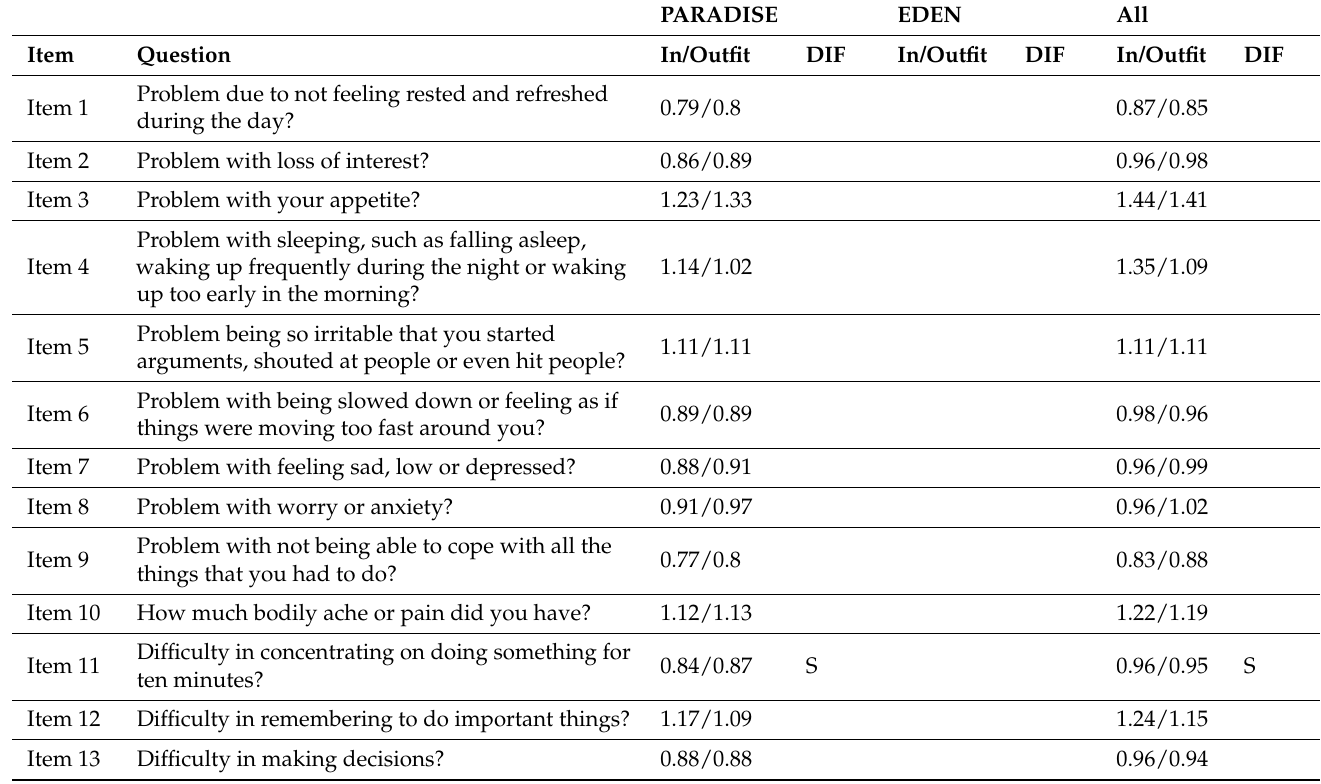
Table 1. Fit of items including infit and outfit statistic and presence of DIF for the 24 Paradise items, the 18 additional Eden items, and the two